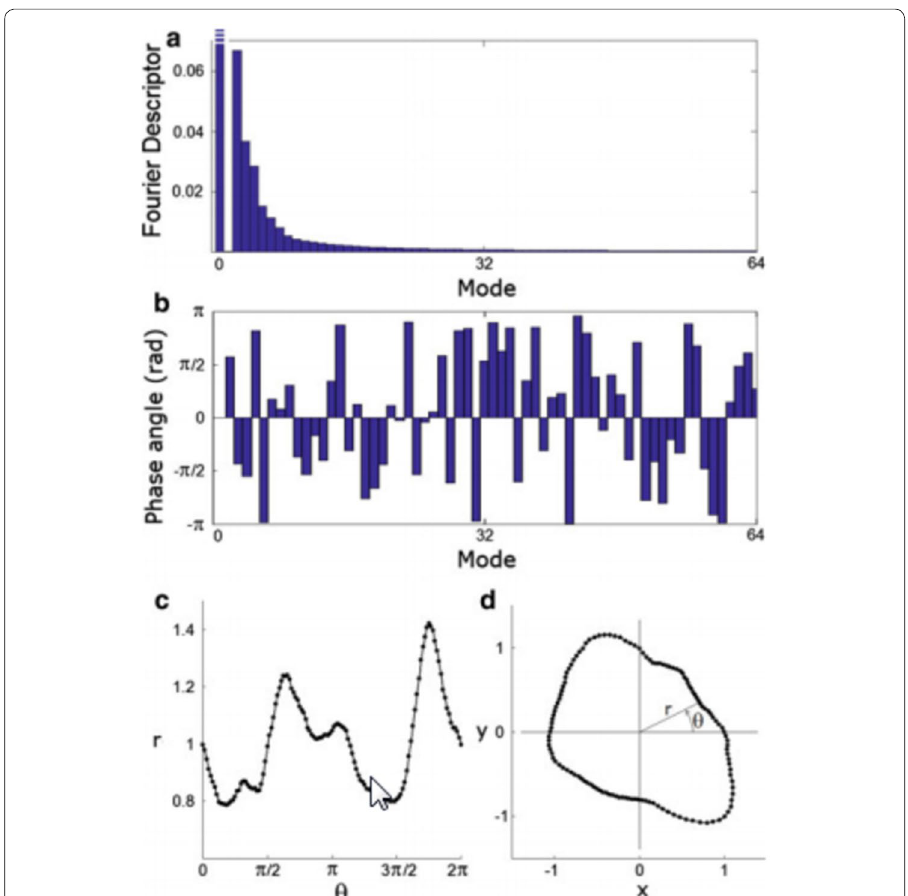
Fig. 2 a Illustrative discrete Fourier spectrum; b random sampling of phase angles; c corresponding r(θ) discrete signal; d particle contour in a Cartesian